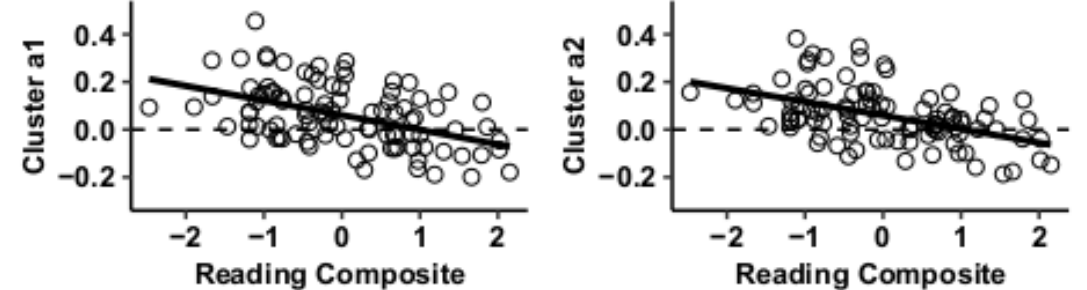
Figure 3. Whole-brain functional connectivity correlations with reading composite score for MVPA cluster a.